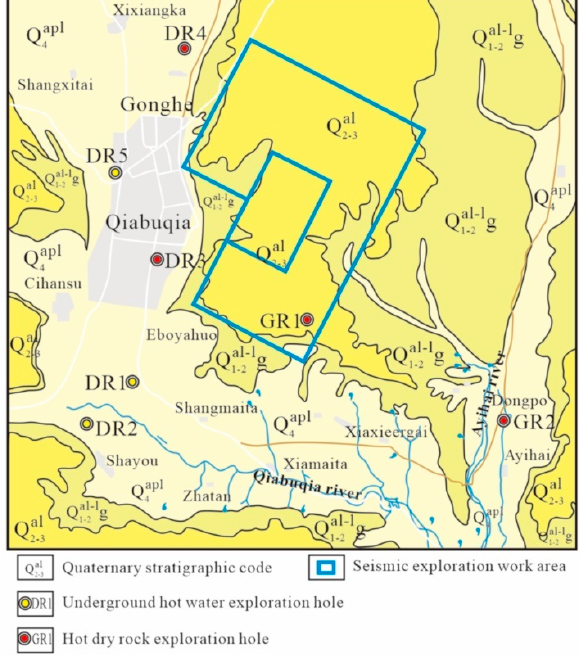
Figure 1. Geological background and distribution of the study area (adapt from Zhang Senqi, 2018) [27].